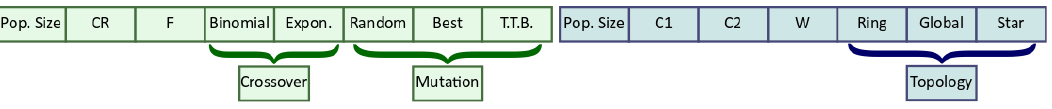
Figure 3. Encoding of DE (left) and PSO (right) configurations in a tuner EA.